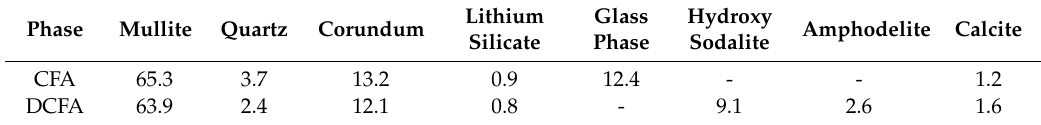
Table 3. Mineralogical analysis of CFA and DCFA (wt %).